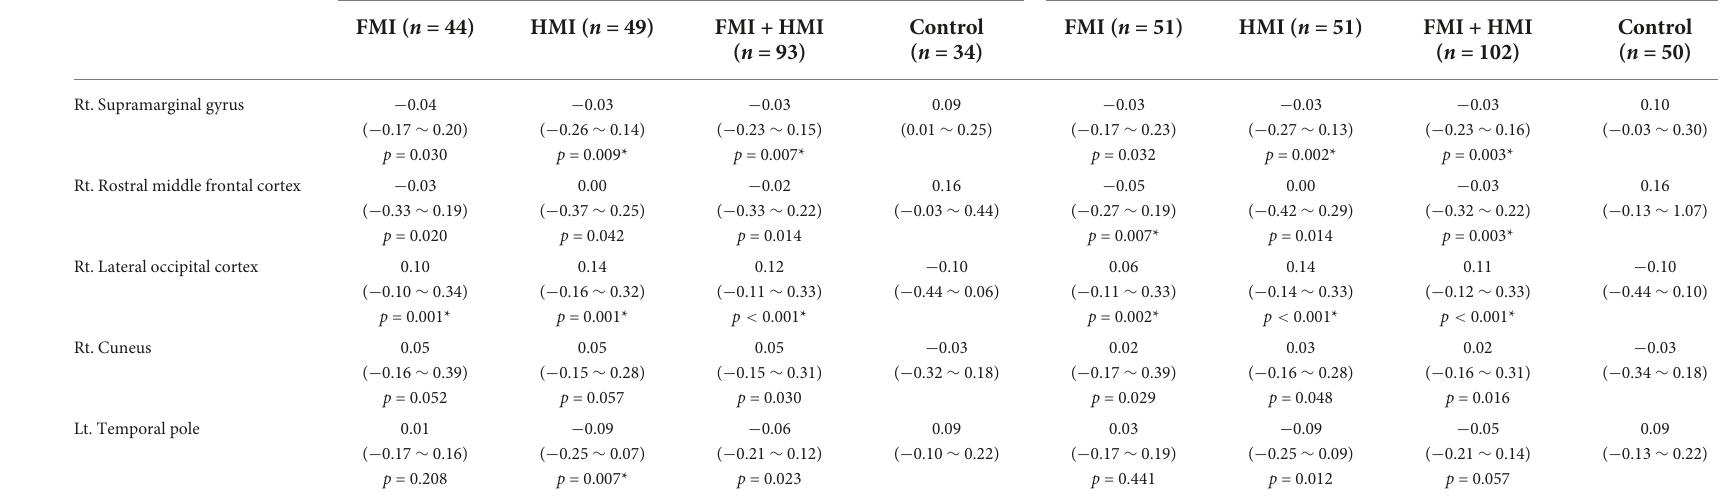
TABLE 3 Comparison of changes in characteristic path length of alpha1 band between the intervention and control groups. Changes from baseline to study end excluding missing data